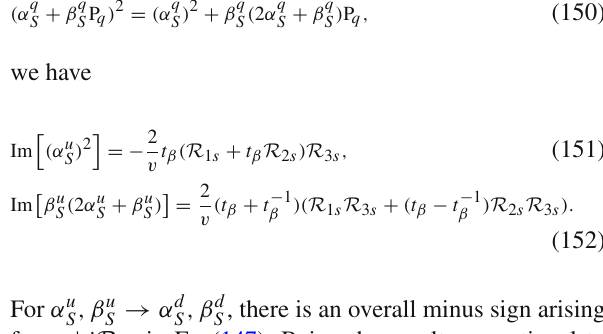
Fig. 12 Function F ( a ) in